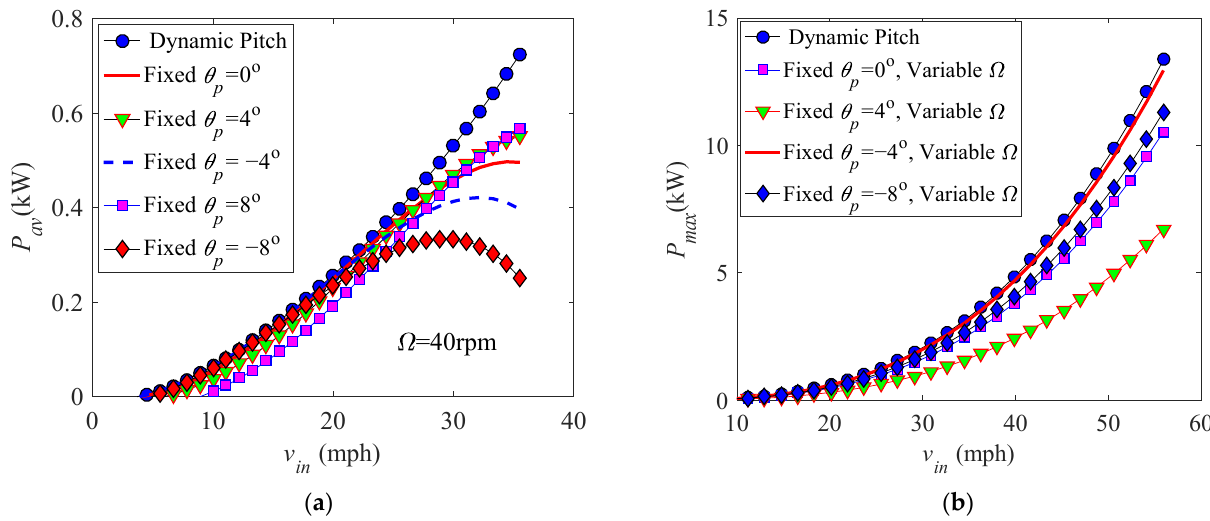
Figure 24. Verification of the efficiency of the dynamic-pitch optimization for ( a ) constant-speed blades and ( b ) variable- speed blades.